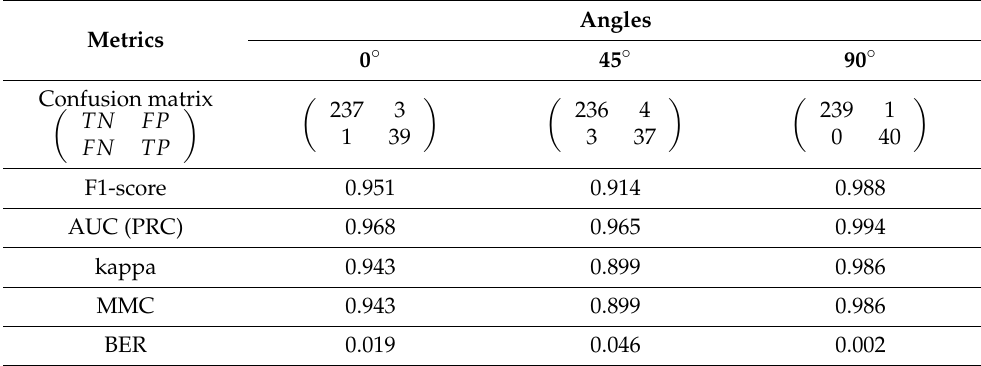
Table 2. Ratio of correctly predicted classes for each position, angle, and movement for the RGB data from the 20-subject group (each 0.05 in the value accounts for a corrected predicted video). No Movement Head One Arm Both Arms One Leg Both Legs Slight Sitting 0 ◦ 0.95 1.00